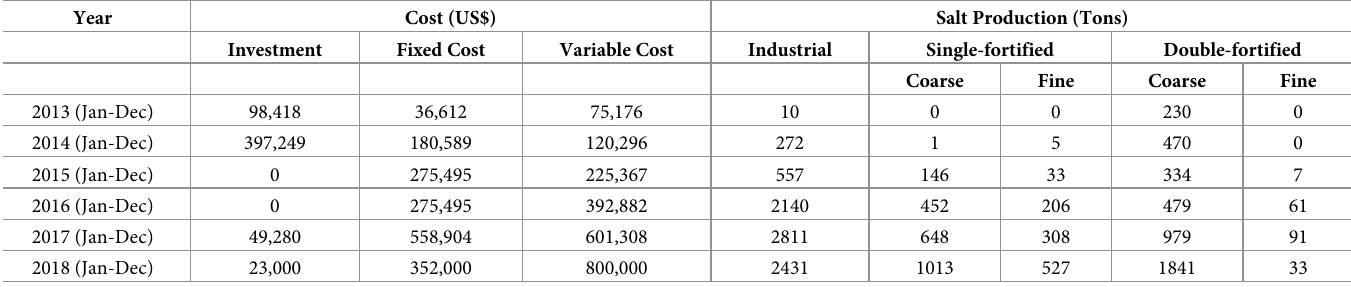
Table 1. Cost (investment, fixed cost and variable cost (in US$)) and summary of all types of salt (industrial salt, coarse and fine single-fortified salt, and coarse and fine double-fortified salt) produced (tons) from